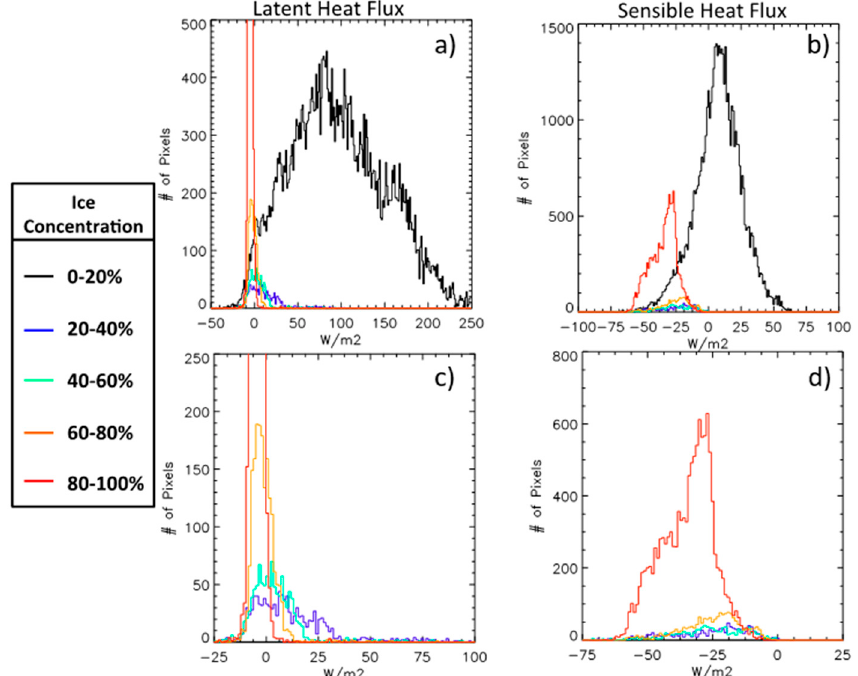
Figure 4. Histograms of monthly average, satellite-retrieved ( a , c ) LH and ( b , d ) SH fluxes [57] stratified by monthly average sea ice concentration from passive microwave retrievals between 2003–2015. Histograms on the bottom show the same data as the top panel with a different scale and sea ice concentrations ranging from 20–100%. The regions include 2–15 (excluding 12 and 13) in Figure